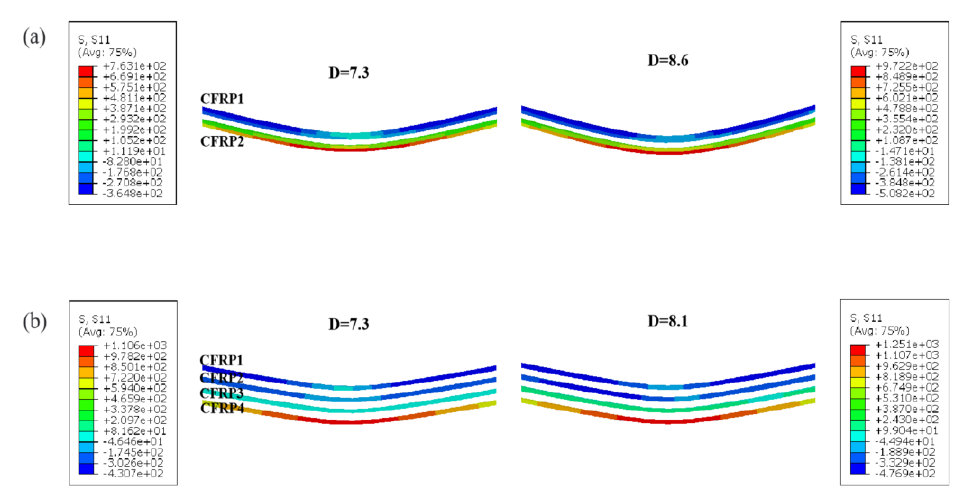
Figure 7. Longitudinal stress contours of 2/1 FMLs and 2/1 FMLs patch after failure (a) 2/1 FMLs, (b) 3/2 FMLs patch. (On the left is the Linde criterion and on the right is the Hashin criterion).